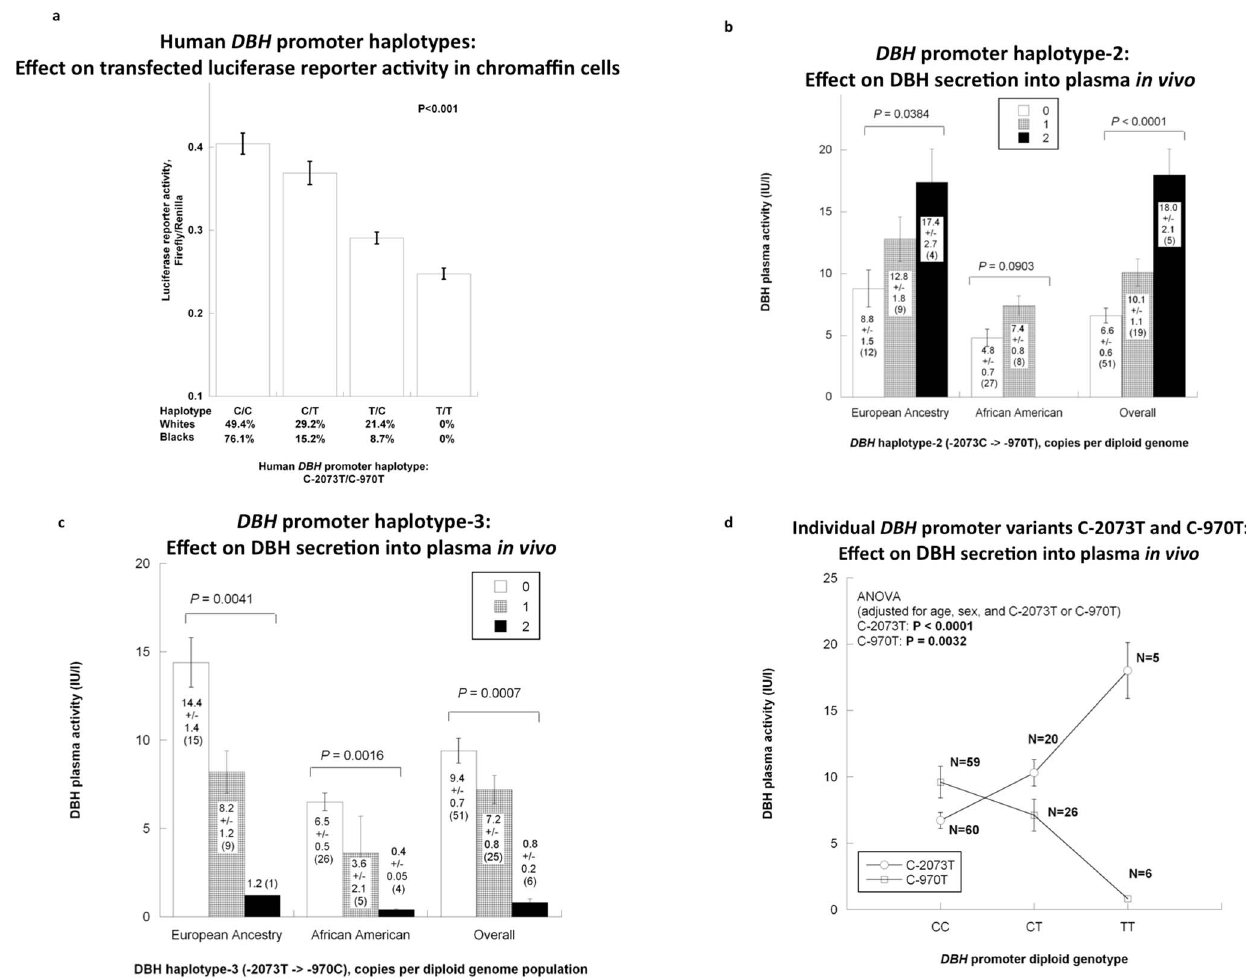
Figure 3. DBH promoter haplotypes (C-2073T R C-970T): Results for haplotype/luciferase reporter enzymatic activity in transfected chromaffin cells, as well as DBH secretion in humans. a. DBH promoter haplotype expression in the nucleus : Transcription in luciferase reporter plasmids transfected into chromaffin (PC12) cells. Each promoter transfection was done in 8 replicates. b. DBH promoter haplotypes in vivo : Effects on plasma DBH activity . Two functional promoter SNPs constituting a haplotype are shown in subjects of European ancestry, African American and the overall population. Haplotype-2 (C R T) is significantly associated with DBH activity in subjects from European ancestry as well as the overall study population. c. Haplotype-3 (T R C) is significantly associated with DBH activity in all groups. d. Common promoter variants C- 2073T and C-970T analyzed individually for effects on DBH secretion invivo . Plasma DBH activity shows significant association with each of the common variants, both C-2073T and C-970T. To attain specificity, C-2073T or C-970T (as appropriate) were included as covariates, along with age and sex. doi:10.1371/journal.pone.0082956.g003 American subjects as compared to other ethnicities in the twins/ siblings (Table S3c in file S1; p =0.0041), though not between blacks in the twin/sibling versus AASK (p= 0.99); especially prominent was the increased frequency of haplotype C R C in blacks (from 49.5% of chromosomes in whites, to 76.1% in AASK).